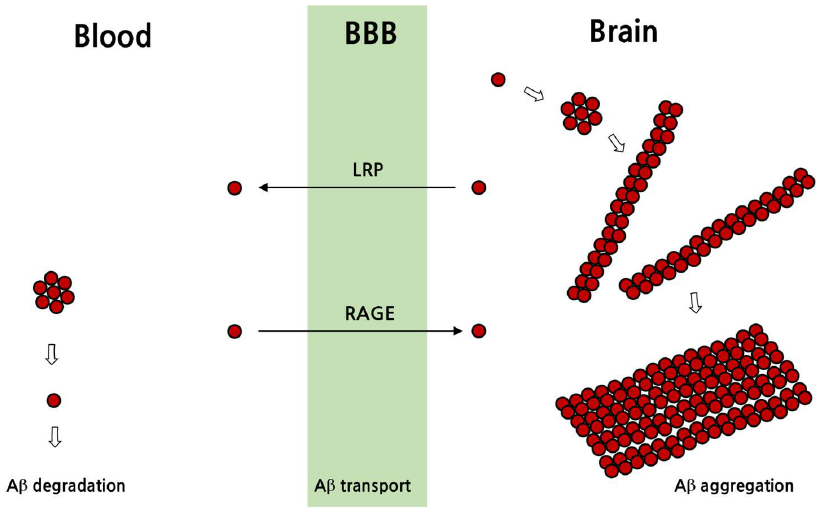
Figure 4. BBB transport of Aβ. Aβ is produced in the CNS, where it can aggregate into insoluble aggregates. Soluble Aβ can be transported across the BBB from brain to blook vis LRP. Aβ is also produced in peripheral tissues and can be transported from blood to brain via RAGE. LRP: low density lipoprotein receptor-related protein 1; RAGE: advanced glycation end product receptor. In addition, ApoE protein is related to the movement, removal, and aggregation of Aβ, and there are three isoforms: apoE2, apoE3 and apoE4. ApoE3 is the most common